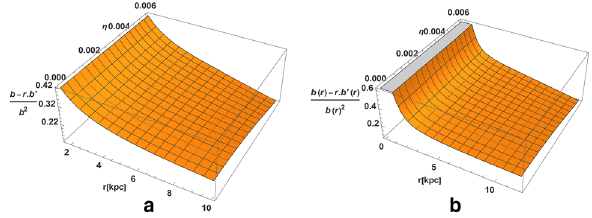
(cid:3) ( r ) Fig. 11 Thefunction b ( r ) − r × b withrespectto r ( kpc ) and η isplotted b 2 ( r ) by using ρ 0 = 0.05 kpc − 2 , r 0 = 1 kpc with 0 ≤ η ≤ 0 . 006 for a NFW profile : r th = 1 . 7 kpc , b URC profile : r th = 1 kpc